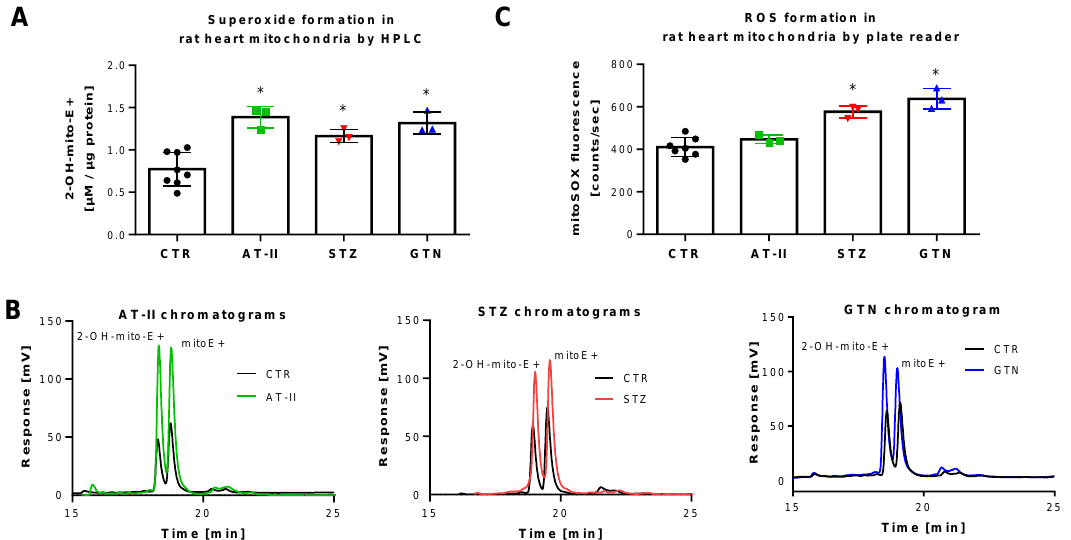
Figure 4. Detection of superoxide generation by mitochondria from rats with preestablished cardiovascular disease or pharmacologically induced oxidative stress by mitoSOX HPLC. The yield of the superoxide-specific mitoSOX oxidation product 2-OH-mito-E + in mitochondrial preparations of hypertensive (AT-II), diabetic (STZ) and nitrate tolerant rats (GTN), and respective control animals ( A ). Representative chromatograms are shown for the HPLC-based quantification of 2-OH-mito-E + ( B ). In the same mitochondrial preparations, also ROS formation was measured using a fluorescence plate reader assay for the mitoSOX oxidation products in all groups ( C ). Data are mean ± SD of 7 (Ctr) and 3 (AT-II, STZ, GTN) rats per group. Each single animal data point was generated from up to 2 ( A ) or 2–3 ( C ) technical replicates. * p < 0.05 vs. control